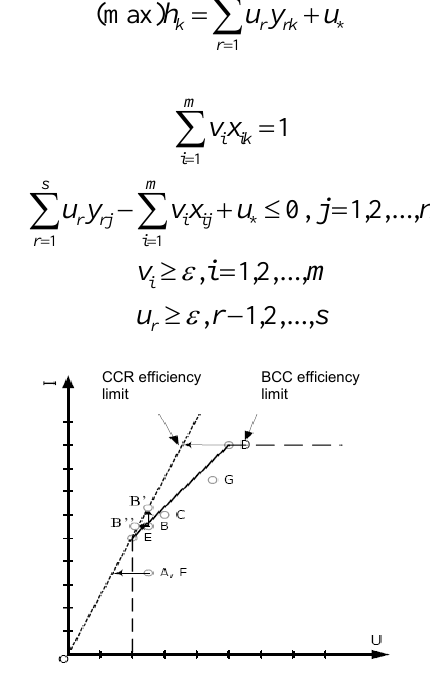
Figure 1 – Forms of efficiency limit Рис . 1 – Пределы эффективности Слика 1 – Облици границе